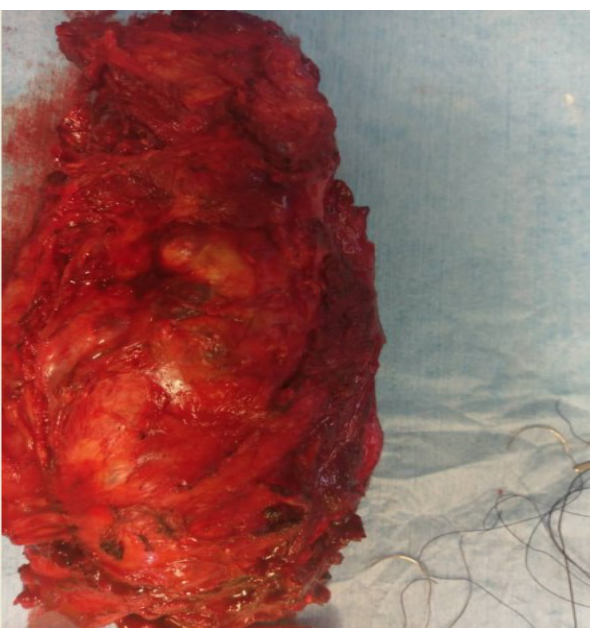
Figure 2: A macroscopic photograph showing of